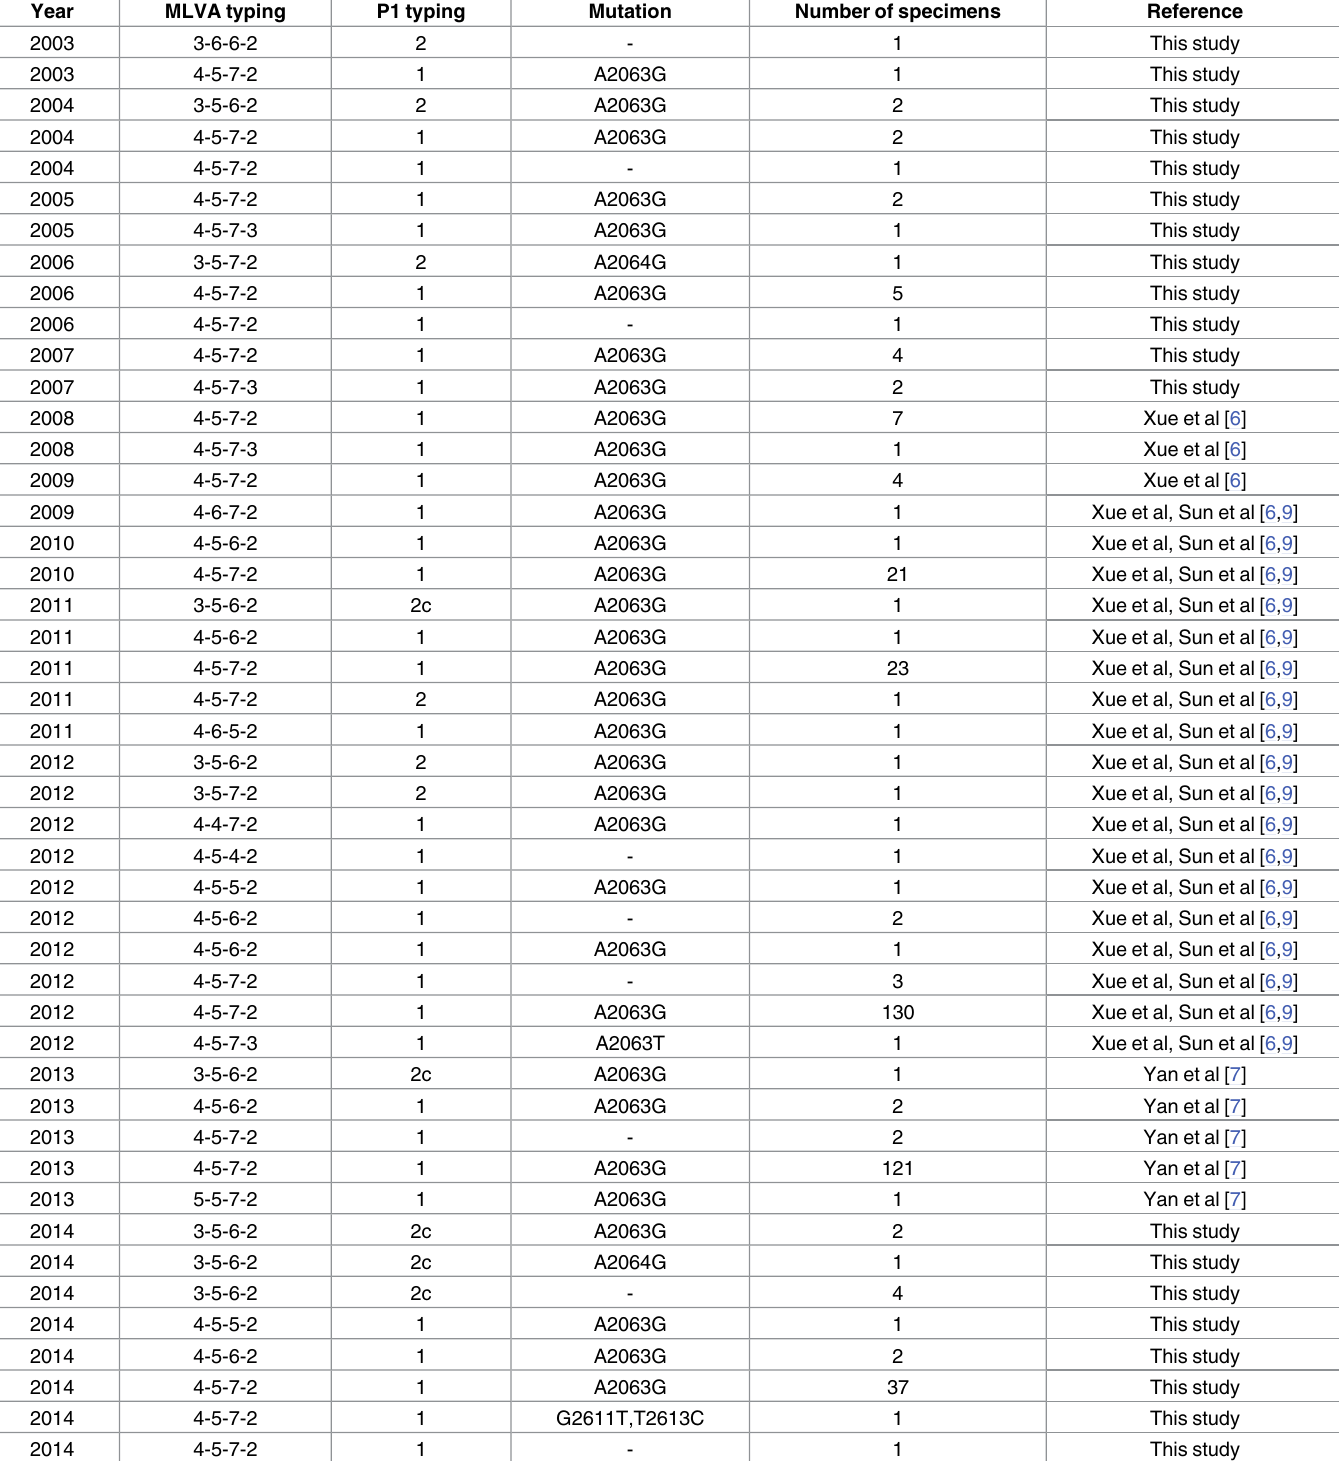
Table 1. Genotyping and macrolide resistance mutation results for Mycoplasmapneumoniae in clinical specimens collected from children in Bei- jing between 2003 and 2015.